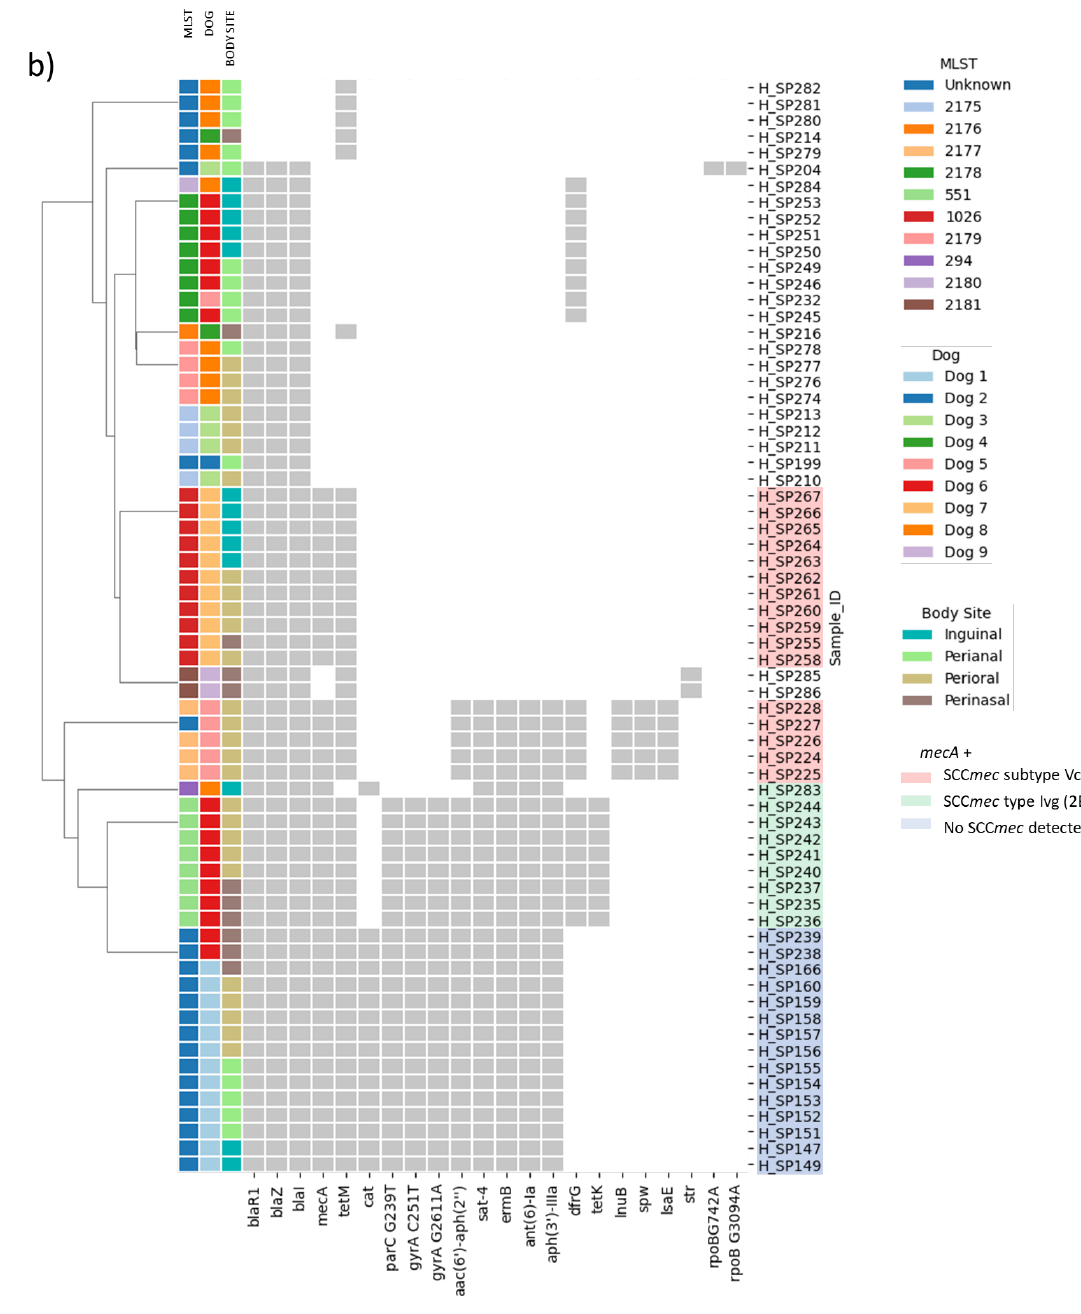
Figure 1. Continuation. Clustermaps for the ( a ) phenotype and ( b ) genotype results. For both clus- termaps, the first three columns correspond to Multilocus Sequence type (MLST), dog number, and body site, respectively. For ( a ) phenotype clustermap, dark gray represents resistance and light gray represents intermediate susceptibility. In the ( b ) genotype clustermap, the absence/presence of antibiotic resistance determinants (genes and point mutations described in this study) are represented. SCC mec types are highlighted in the right side of the panel: light red for SCC mec subtype Vc; light green for SCC mec type Ivg (2B); and light blue for those strains that harbored the mecA gene, but no SCC mec was detected by https://cge.food.dtu.dk/services/SCCmecFinder/ (accessed on 21 October 2022).